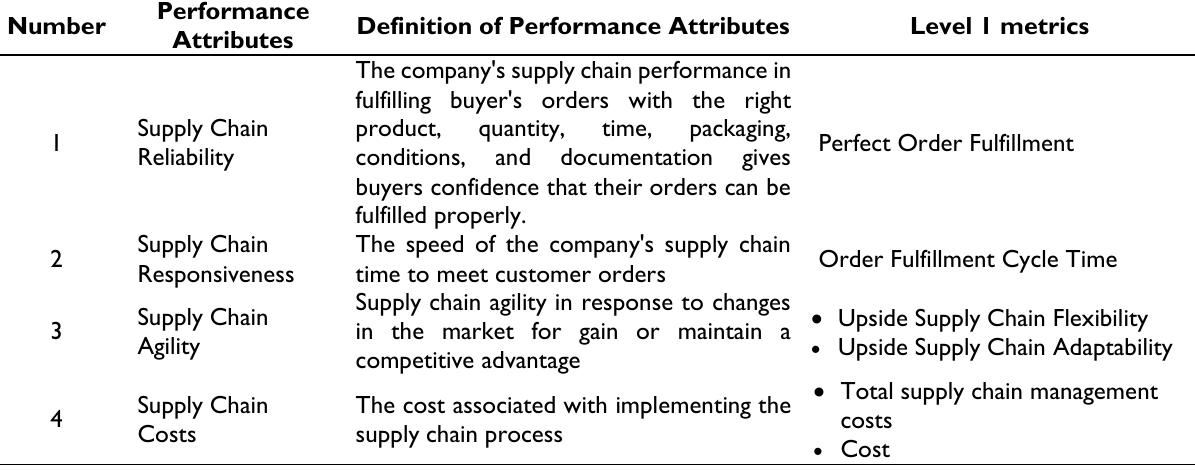
Table 2. Performance Attributes and Metrics in